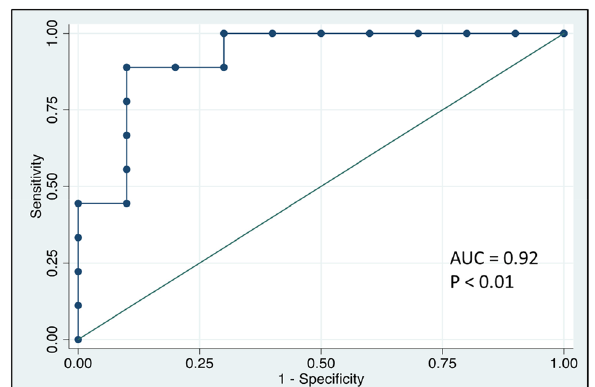
Figure 6: ROC curve analysis to test the validity of Bcl3 gene expression in discriminating samples of patients and